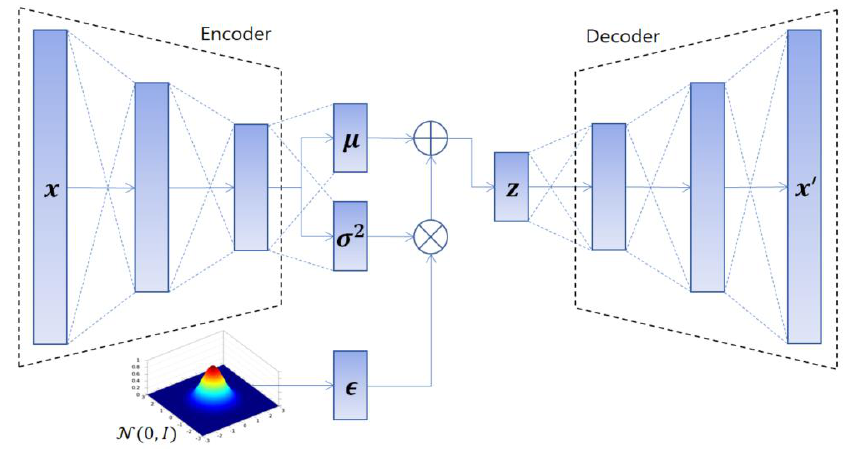
Figure 2. Variational auto-encoder (VAE) structure.